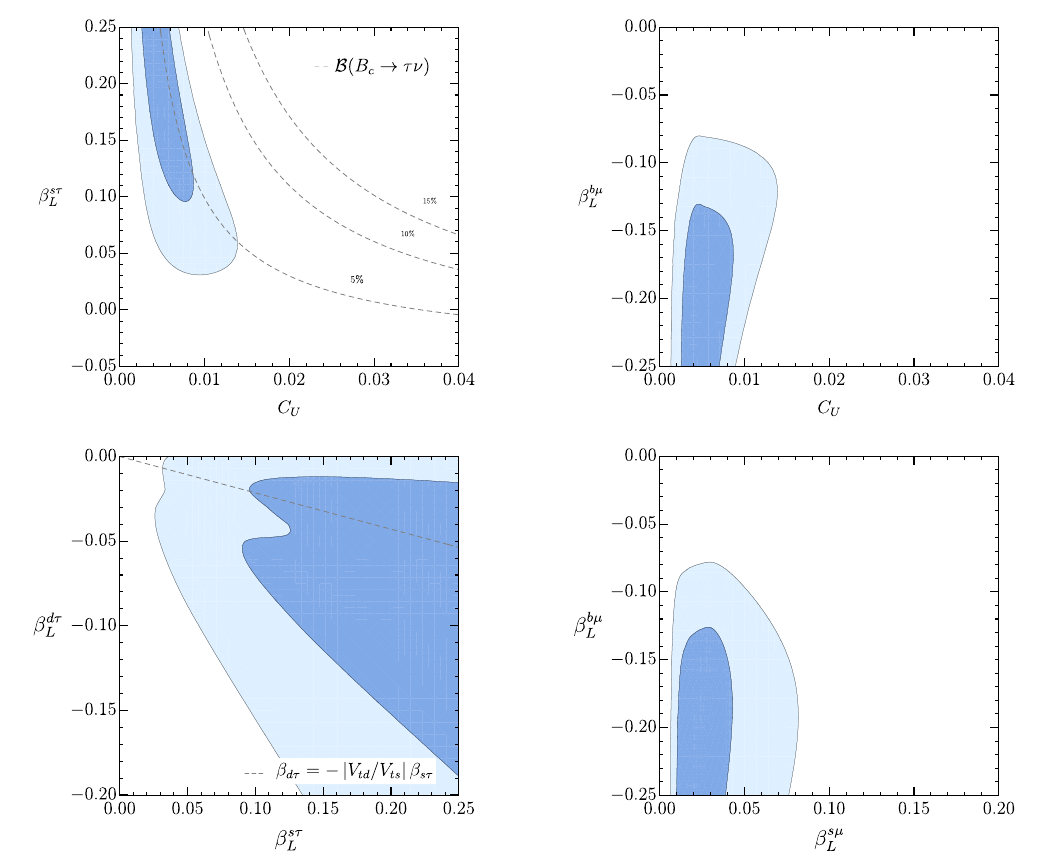
Figure 2 . Preferred 2D regions from the fit, marginalizing over the rest of the parameters. The 2 . 30 (1 σ ) and ∆ χ 2 6 . 18 (2 σ ) regions are shown in blue and light blue, respectively. ∆ χ 2 ≤ ≤ ) assuming R to be fixed to their current experimental central Dashed isolines for ( B c → τν D ( ∗ ) B values are also